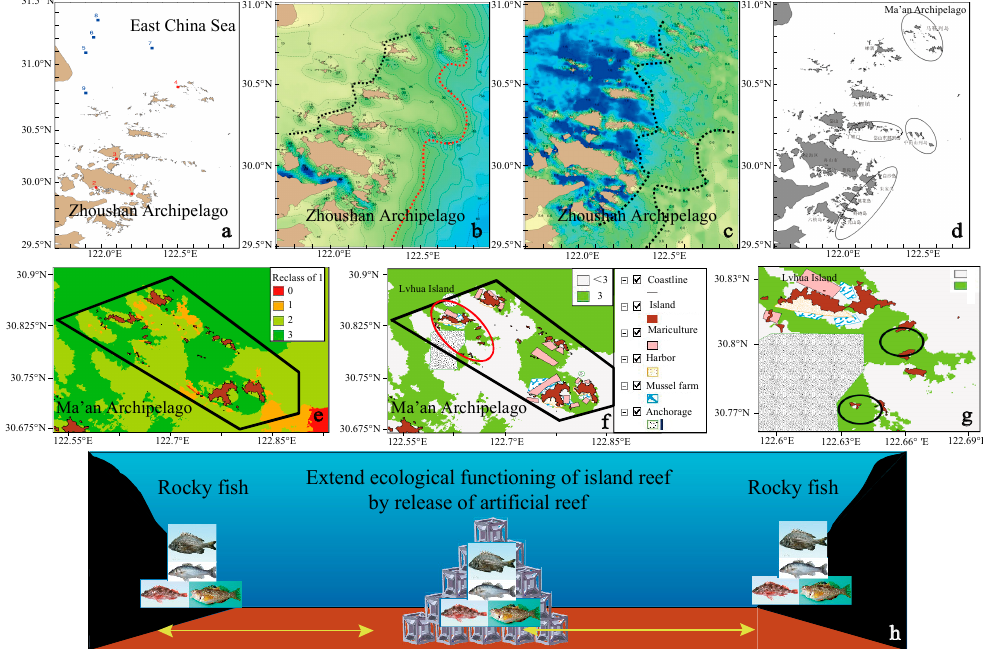
Figure 1. A step-by-step procedure for artificial reef construction site selection and design in the East China Sea (ECS): ( a ) obtain an approximate area for the proposed artificial reef; ( b ) determine depth distribution and the appropriate area for the artificial reef based on water depth; ( c ) determine turbidity distribution and the appropriate area for the artificial reef based on turbidity; ( d ) preliminary potential artificial reef site integrating depth, turbidity, and expert suggestions; ( e ) narrowing the field of potential construction areas where potential sites should be classified and graded using the analytic hierarchy process (AHP) method; ( f ) integrate the marine spatial uses of different stakeholders; ( g ) determine the appropriate construction area; and ( h ) develop the concept framework of the artificial reef-based island reef functioning enhancement technique.